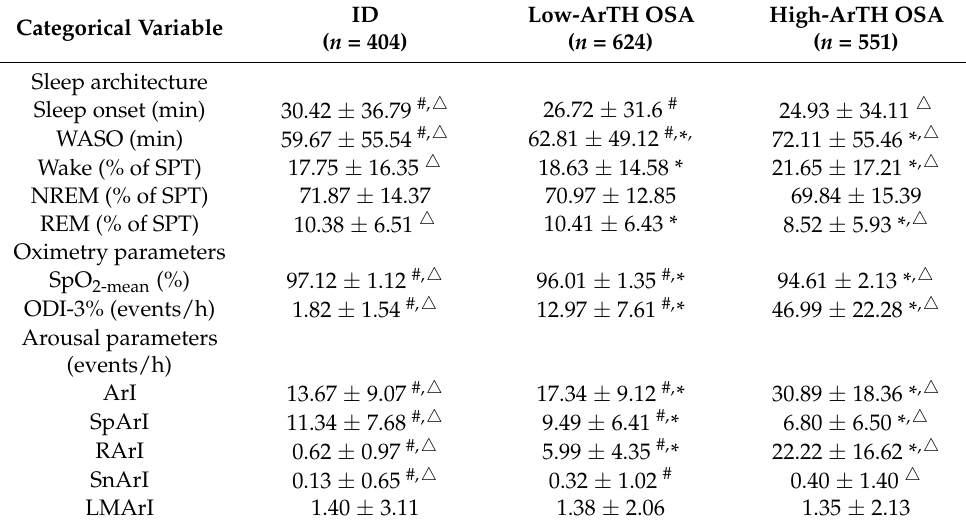
Table 2. Comparison of the PSG parameter results among the three groups. Categorical Variable